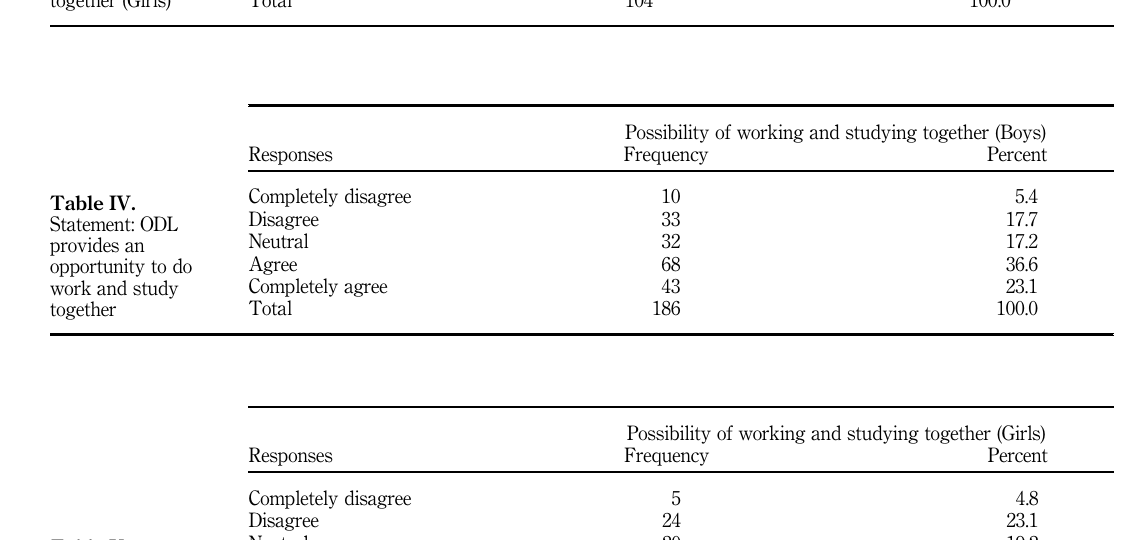
of studying and doing domestic works together (Girls)